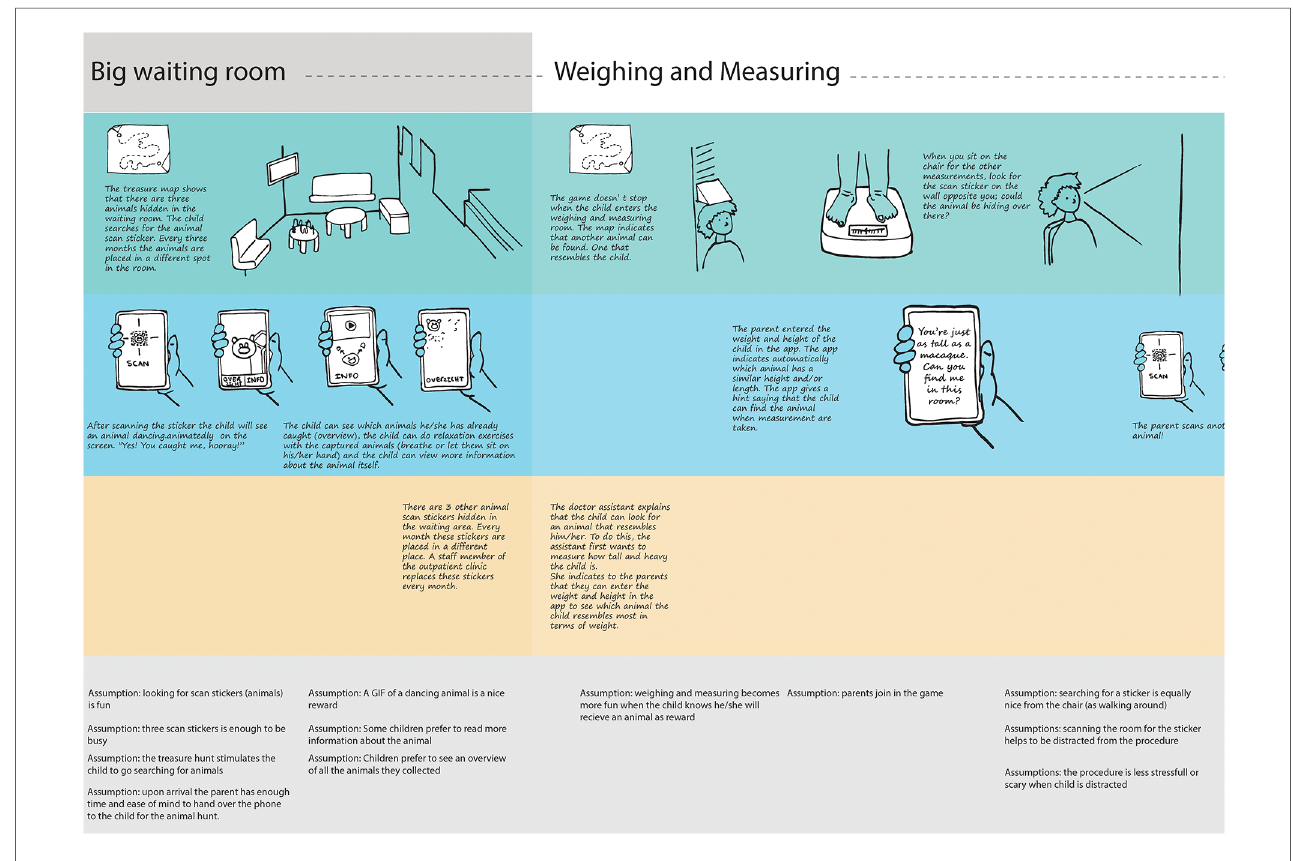
FIGURE 2 Part of the hospital Hero concept journey including the desired experience qualities and design